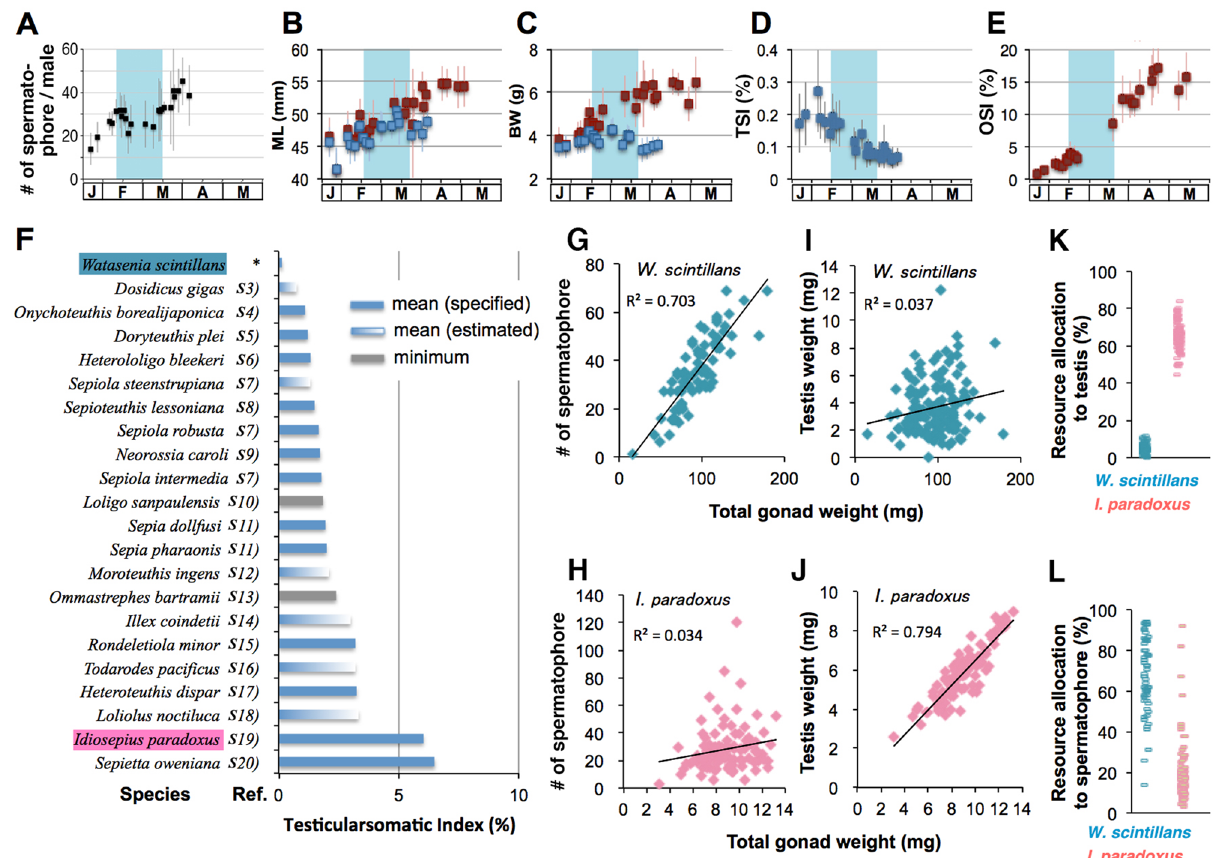
Figure 3. Allocation of male reproductive resources in W. scintillans and other squids . ( A – E ) In W. scintillans, seasonal changes in the number of male-storing spermatophore ( A ), mantle length ( B ), body weight ( C ), testicularsomatic indices ( D ) and ovariansomatic indices ( E ) are plotted as the mean ± SE. Data points represent males in blue and females in red . Cyan boxes indicate the estimated mating period. For ( A – E ), total of 402 males and 950 females were examined. ( F ) A graph showing a comparison of male testicularsomatic indices among previously reported cephalopod species and W. scintillans found in this study (*). Data were extracted from the literature indicated by reference # (Table S1). The columns indicate the mean ( blue column ) or minimum ( gray column ) values specified in the literature, otherwise mean values were estimated ( gradient column ) from presented data points in the graphs. ( G , H ) The GSI values from male individuals are plotted against number of spermatophore ( G , H ) or testis weight ( I , J ) in W. scintillans ( G , I ) and highly promiscuous Idiosepius paradoxus ( H , J ). ( K , L ) In each individual, allocation of male reproductive resources to testis ( K ) or spermatophore ( L ) is expressed in